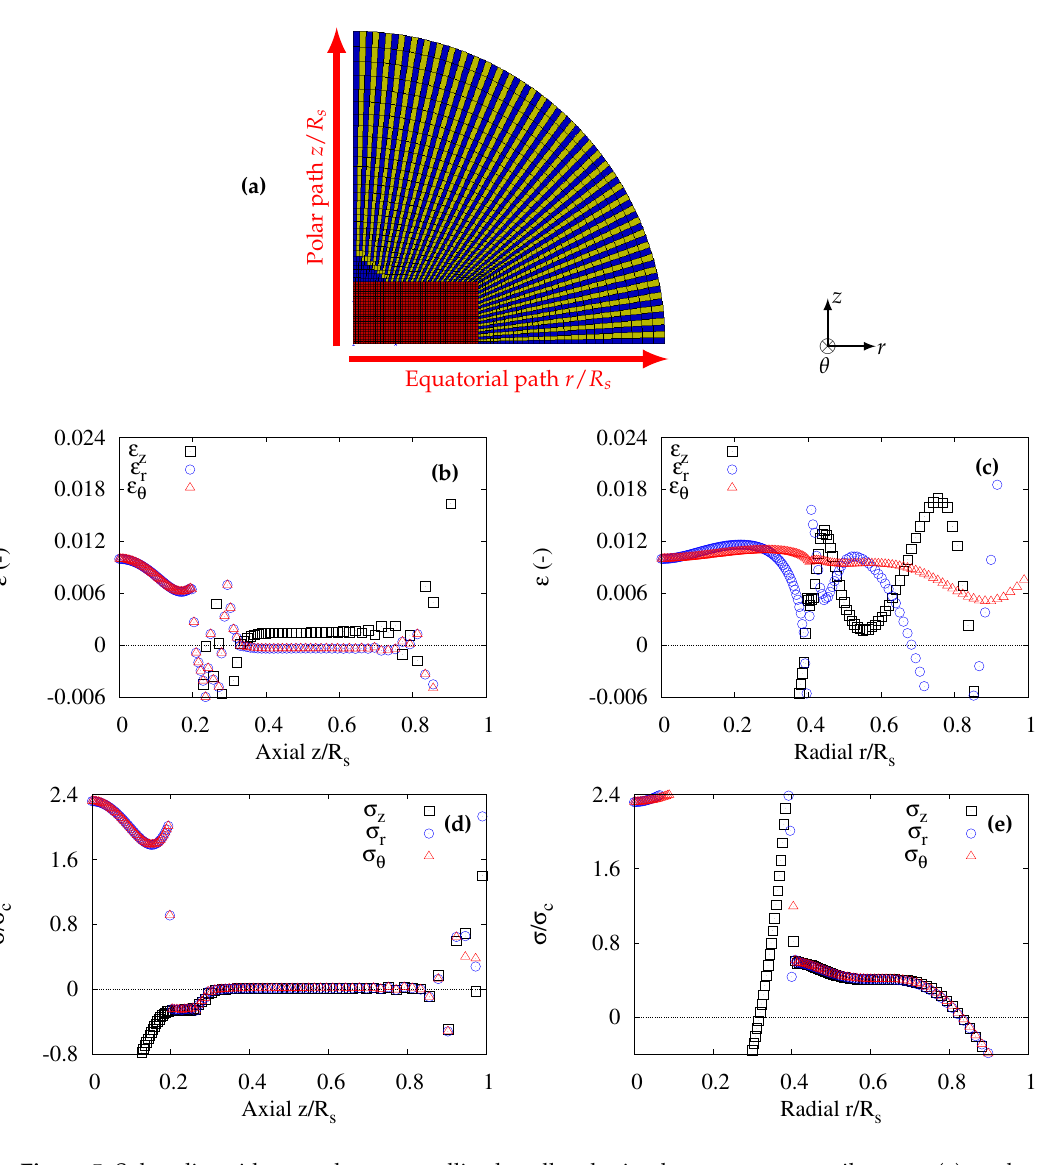
Figure 5. Spherulite with amorphous-crystalline lamellae sbmitted to transverse tensile stress: ( a ) mesh and coordinates; ( b ) strains along the axial path; ( c ) strains along the radial path; ( d ) stresses along the axial path; ( e ) stresses along the radial